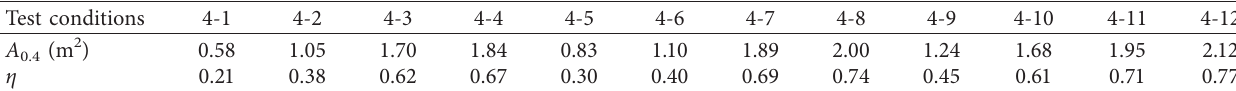
Figure 11: Amplitude reduction ratio contour map for test conditions (a) 4-5, (b) 4-7, and (c) 4-8. Table 11: List of vibration isolation